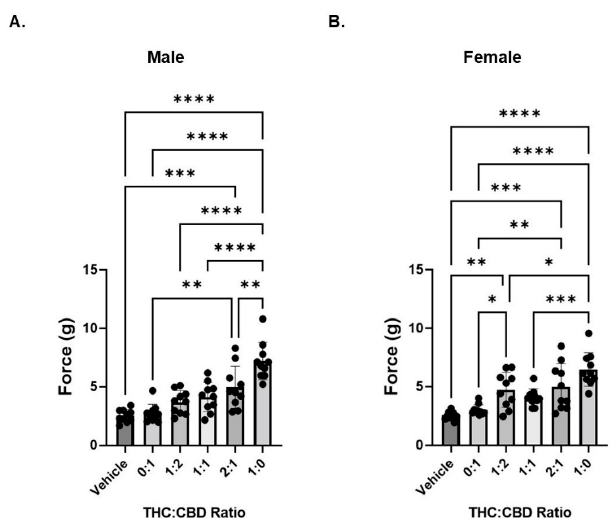
Figure 2. THC reduces mechanical sensitivity in neuropathic mice. ( A ) Neuropathic male mice were treated with 6 mg/kg of total cannabinoid at varying ratios of THC:CBD and mechanical sensitivity was measured by von Frey filament. ( B ) Same as panel A except in female neuropathic mice. n = 10 mice per group. * p < 0.05, ** p < 0.01, *** p < 0.005, **** p <